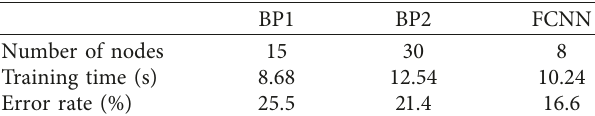
Figure 9: Computational iteration steps on the different number of nodes in the hidden Table 4: Comparison of FCNN and BP.